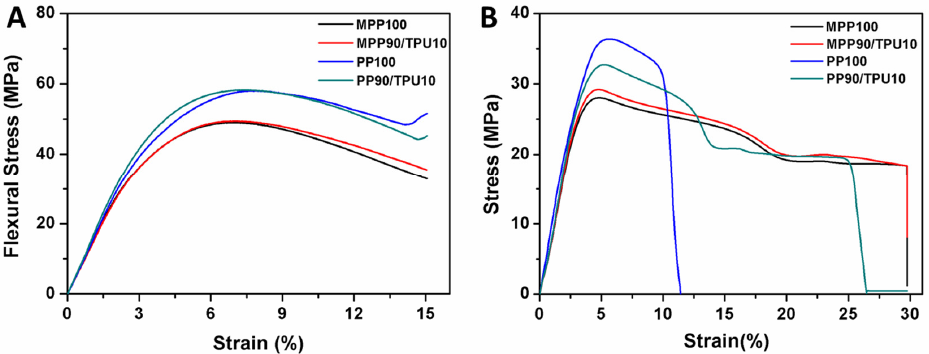
Figure 4. Tensile and flexural behavior of PP/TPU blends and MPP/TPU blends: ( A ) tensile properties and ( B ) flexural properties.